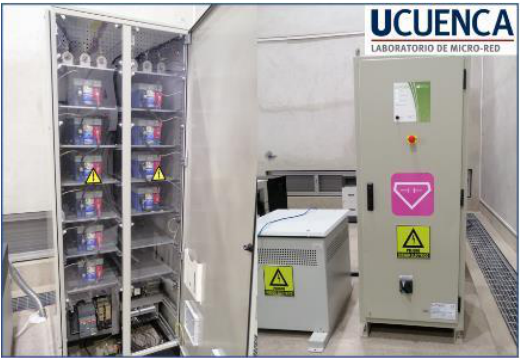
Figure A2. SC – ESS from the micro-grid laboratory: bank of supercapacitors (left), cabinet containing the power electronics converter (right).